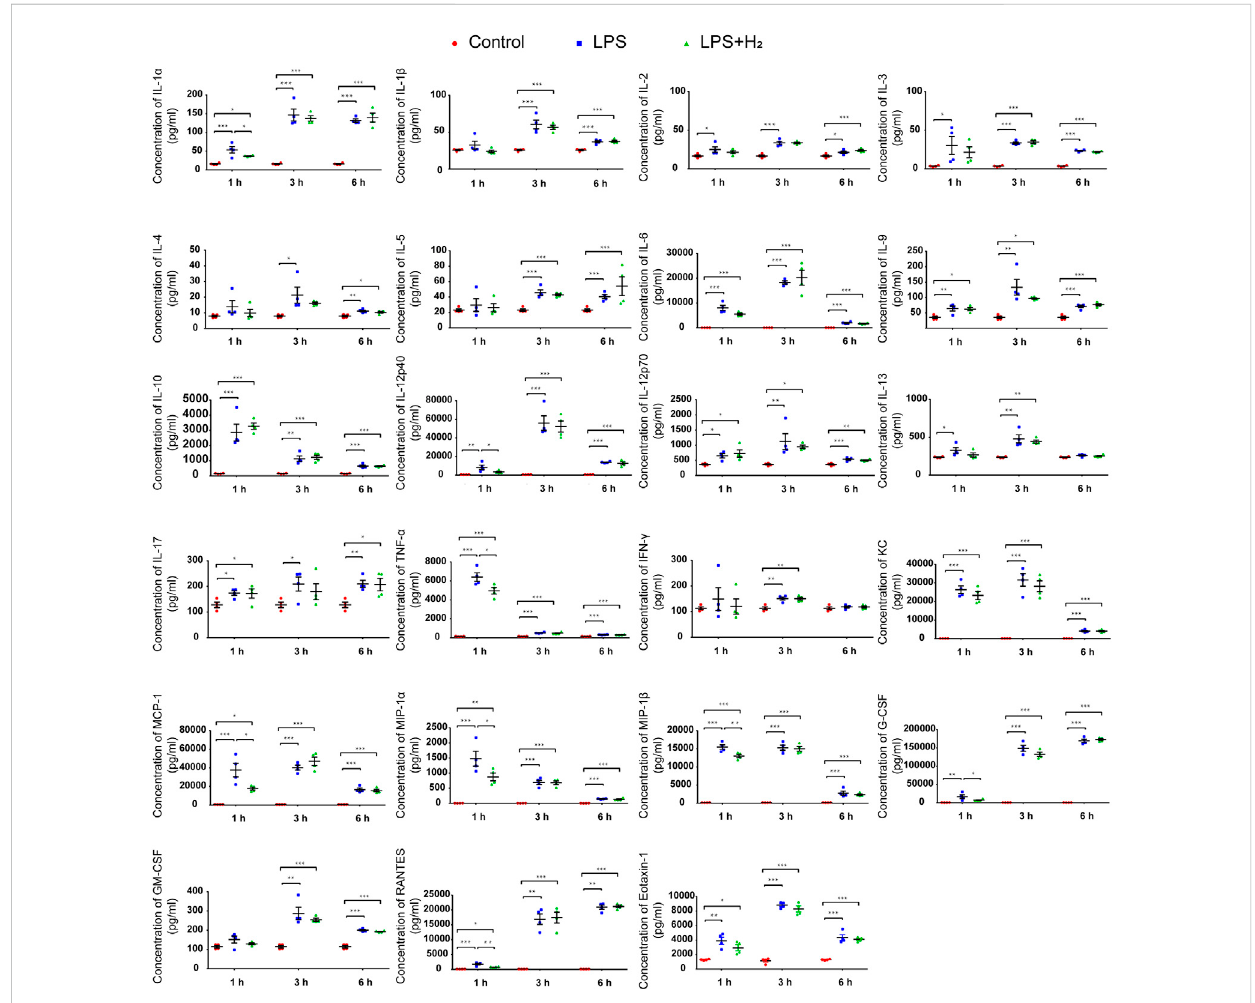
FIGURE 2 Effects ofhydrogenon LPS-induced proteinconcentrations of23cytokinesandchemokinesinmouse serum. Theserum levels of 23cytokines and chemokines from the mice after LPS (2 mg/kg) and/or 42% hydrogen treatment were analyzed in duplicates at 1, 3, and 6 h time points. Data were expressed as mean ± SEM, * p < 0.05, ** p < 0.01, *** p < 0.001, n =